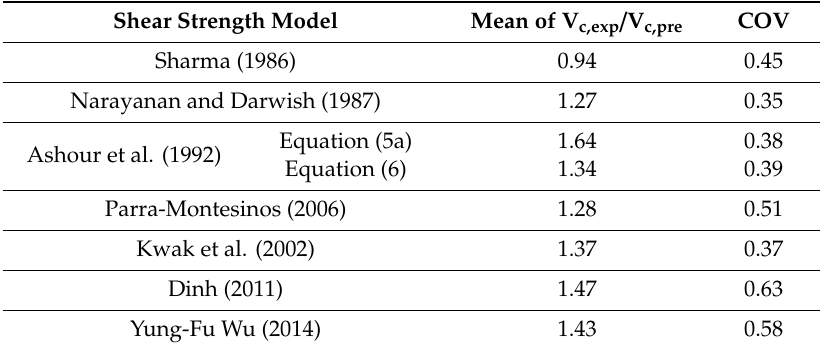
Table 1. Statistical evaluation results for comparison between measured and predicted shear